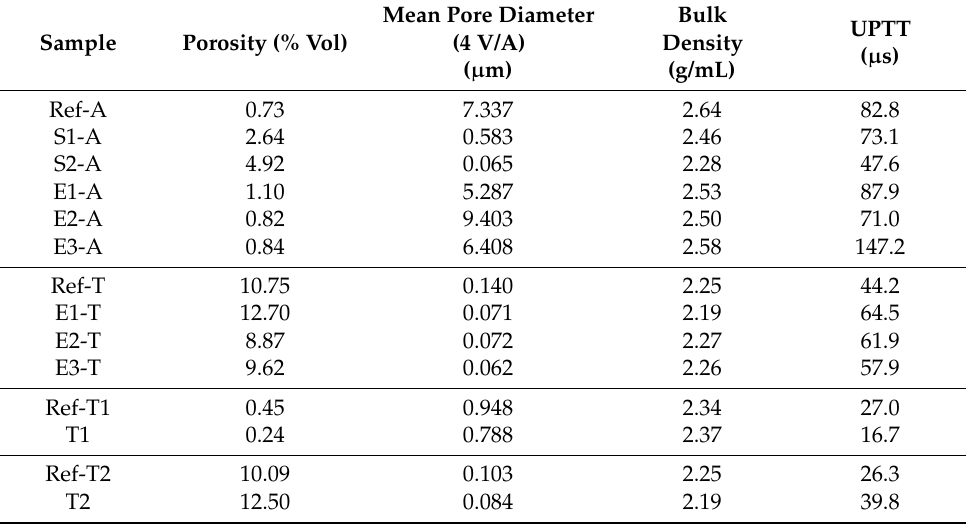
Table 5. Mercury intrusion porosimetry parameters for samples (samples outside the 400 µ m to two transducers spaced on the slab surfaces at a distance of 10